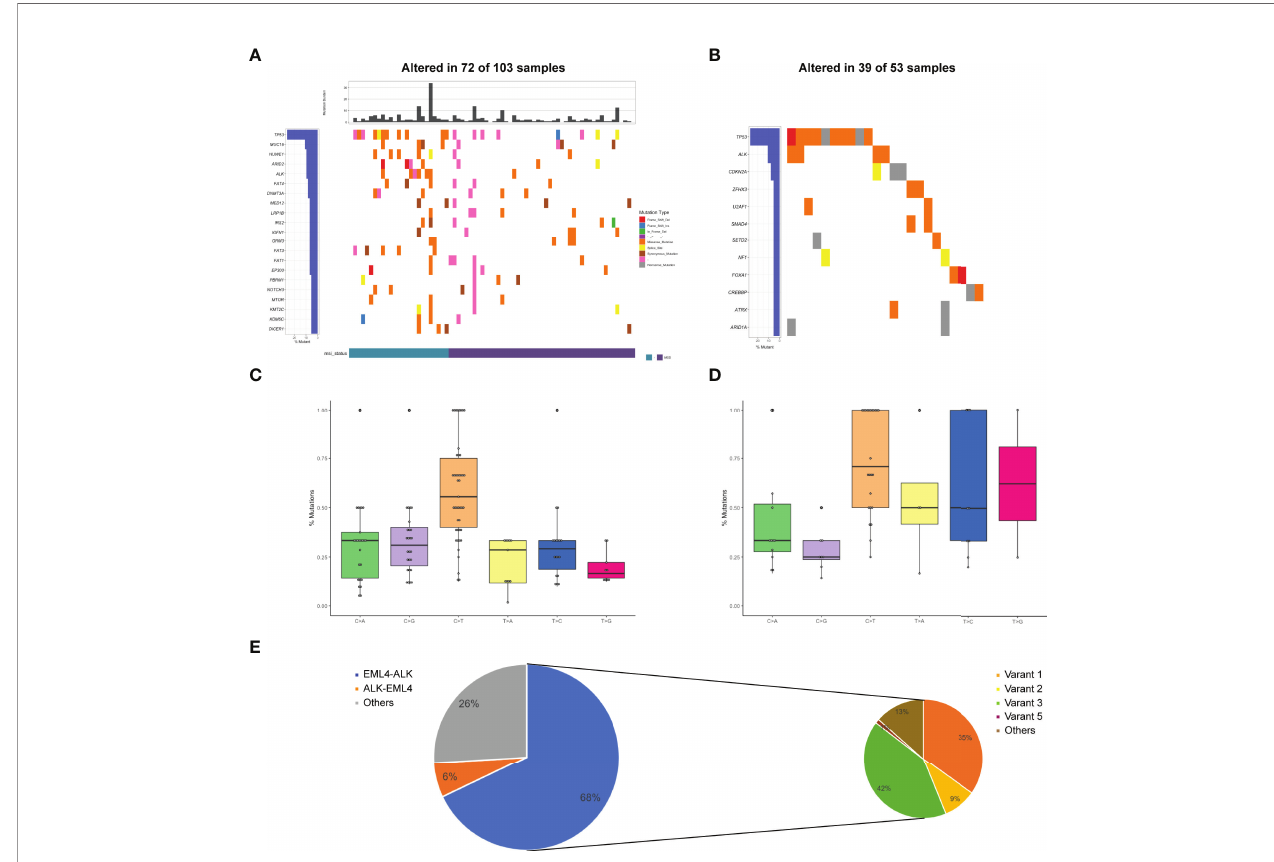
FIGURE 1 | Mutational pro fi les and partners of ALK fusion-positive patients. (A) The oncoprint of the somatic SNVs in 103 patients harboring ALK fusion in our study. (B) The oncoprint of the somatic SNVs in 53 patients harboring ALK fusion in the MSKCC database. (C) Mutational signatures of ALK fusion-positive patients in our cohort. (D) Mutational signatures of ALK fusion-positive patients in the MSKCC cohort. (E) Distribution of ALK fusion partners and EML4-ALK variants. MSI, microsatellite